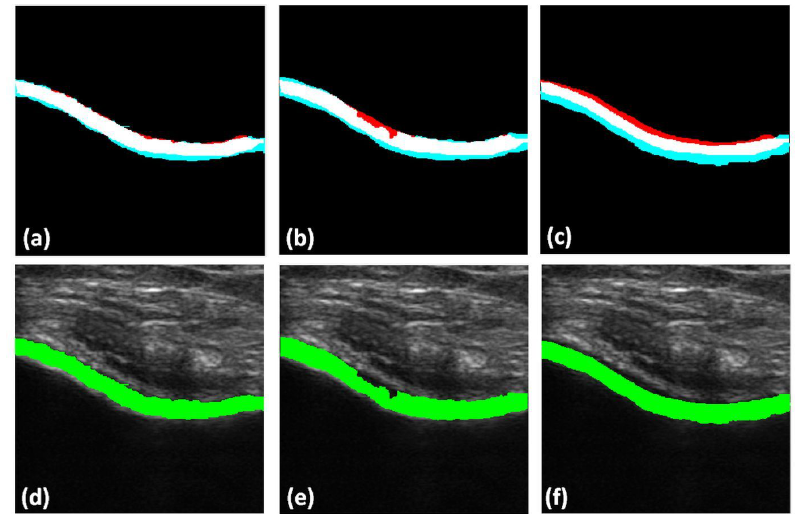
Figure 7. Top row: Qualitative results of automatically segmented cartilage when using USE ( x , y ) as input to the segmentation method, overlaid on the expert manual segmentation (red: false negative, magenta: false positive, white: true positive): ( a ) Manual segmentation overlaid with random-walker (RW) segmentation. ( b ) Manual segmentation overlaid on watershed segmentation. ( c ) Manual